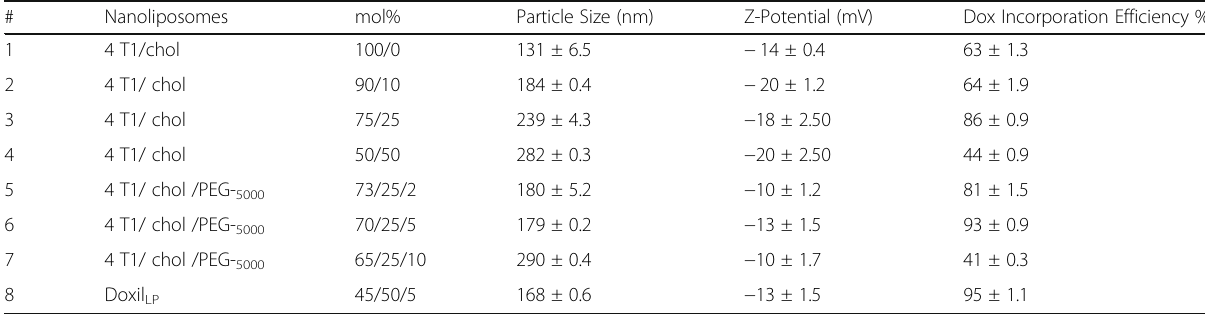
Table 3 Characterization and evaluation of 4 T1 CLENs loading efficiency